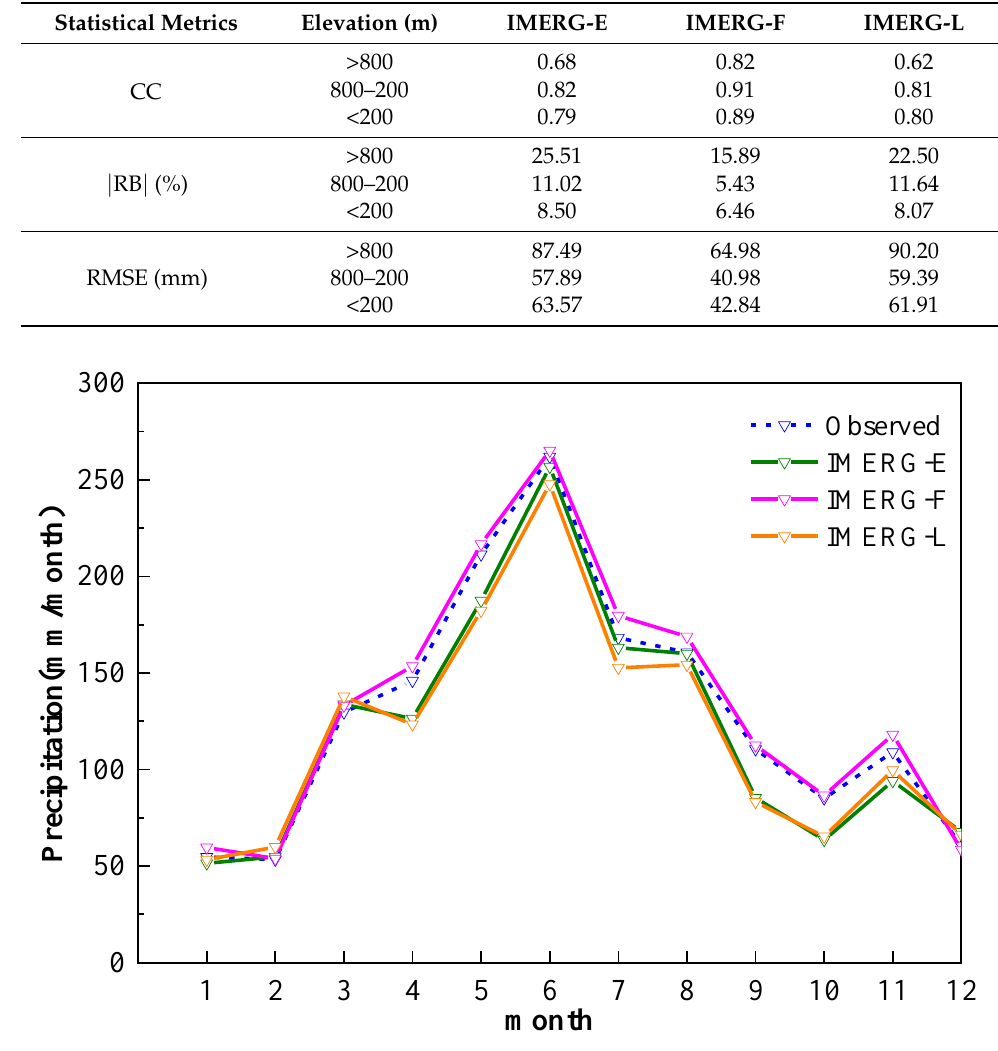
Figure 4. The time series of monthly average precipitation for each month in the Dongting basin based on the observed data and IMERG-E, IMERG-L, and IMERG-F products. The period is from 2015 to 2020.